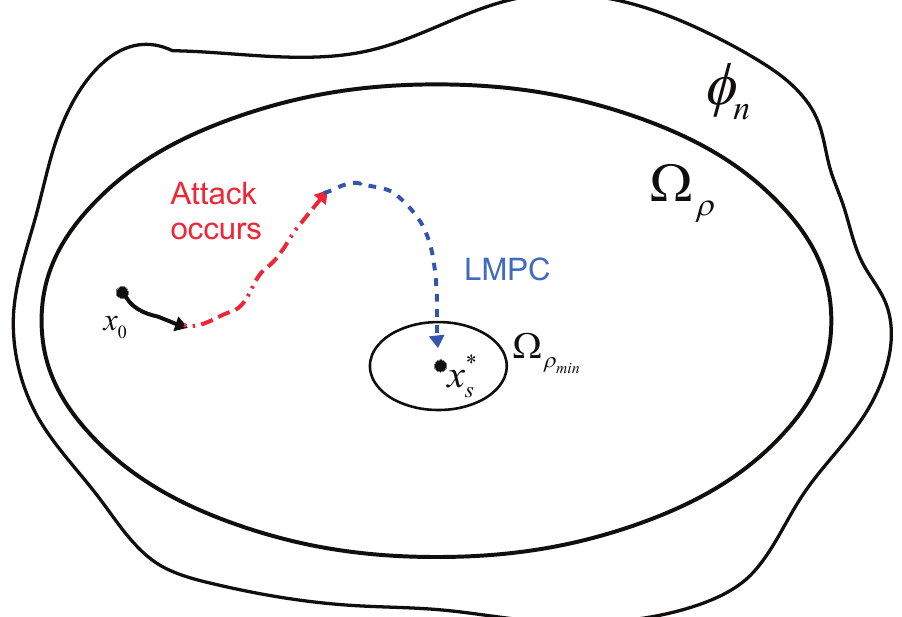
Figure 4. A schematic representing the stability region Ω ρ and the small neighborhood Ω ρ origin. The trajectory first moves away from the origin due to the cyber-attack and finally re-converges to Ω ρ under the LMPC of Equation (14) after the detection of the cyber-attack by the proposed min detection